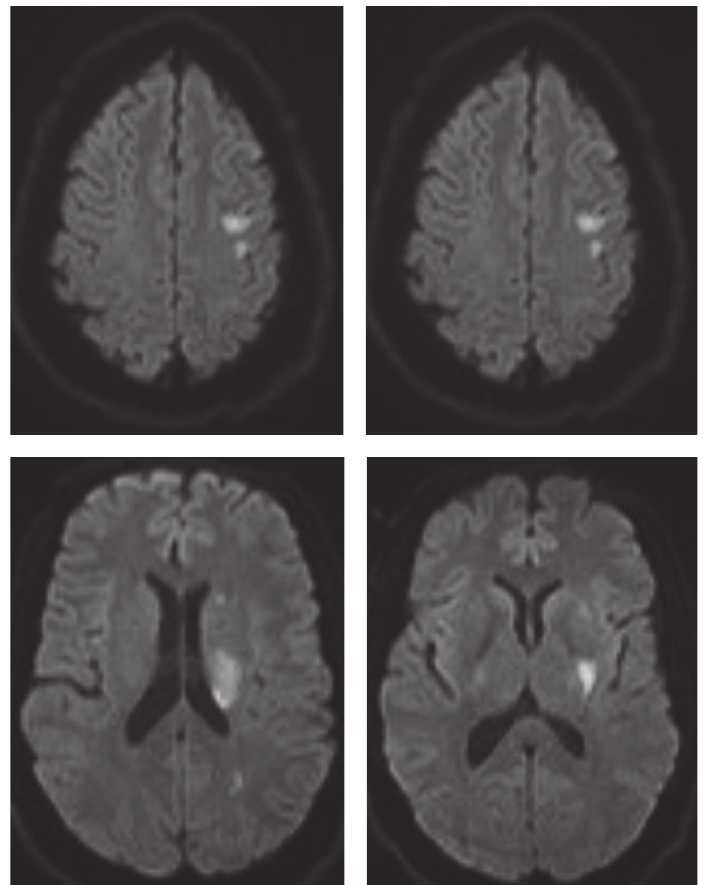
Figure 2: MRI brain DWI sequence demonstrating restriction diffusion in left middle cerebral artery distribution.